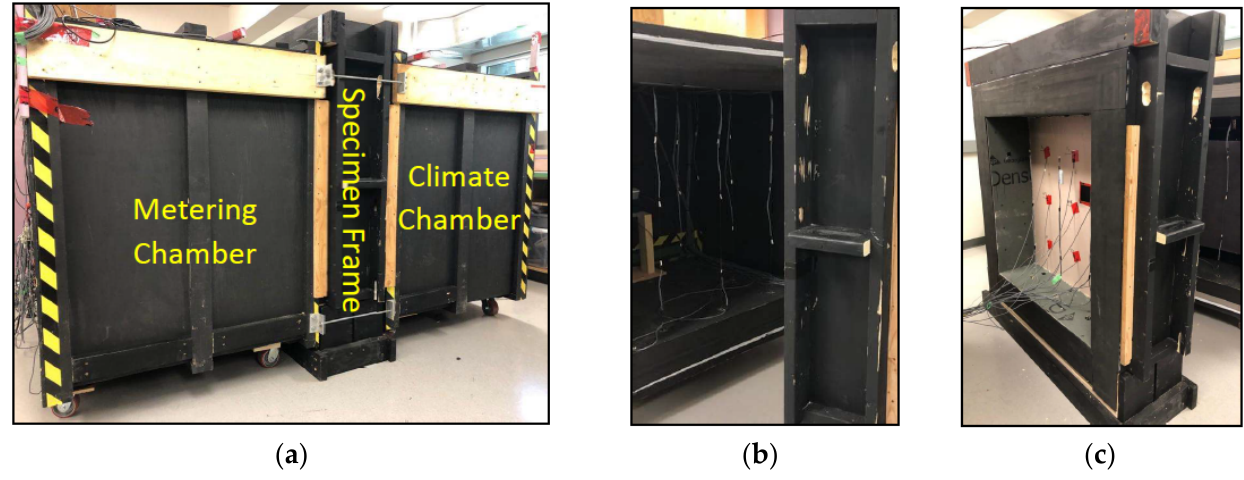
Figure 2. ( a ) Environment chamber; ( b ) interior view of the chamber; ( c ) specimen frame.